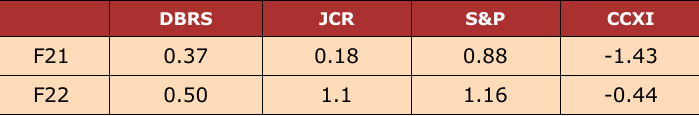
Table 7. The Scores of Principal Component (2)